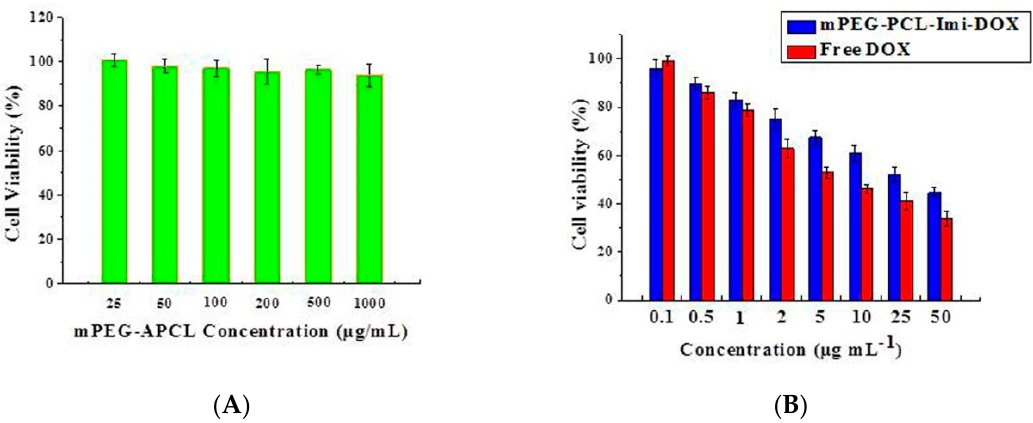
Figure 8. Cell viabilities of MCF-7 cells co-incubated with mPEG-APCL ( A ) and free DOX and mPEG- PCL-Imi-DOX ( B ). Data were presented as mean ± standard deviation (SD) ( n =